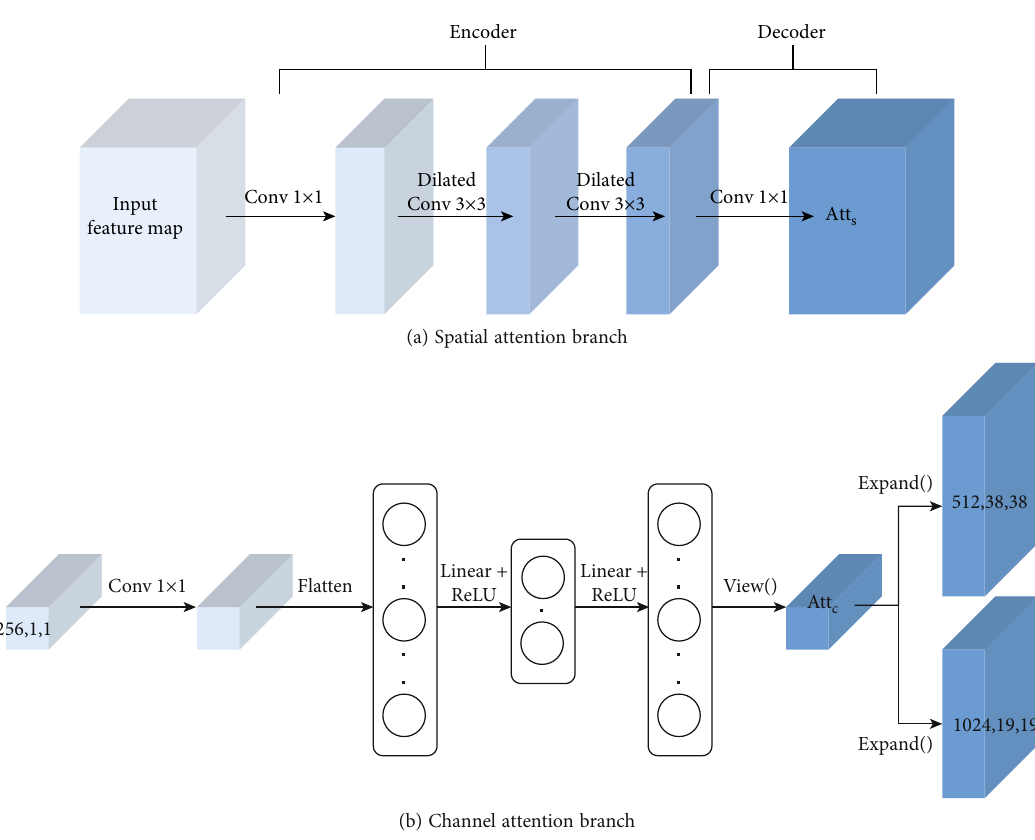
Figure 5: Spatial branch and channel branch in the MA-FF